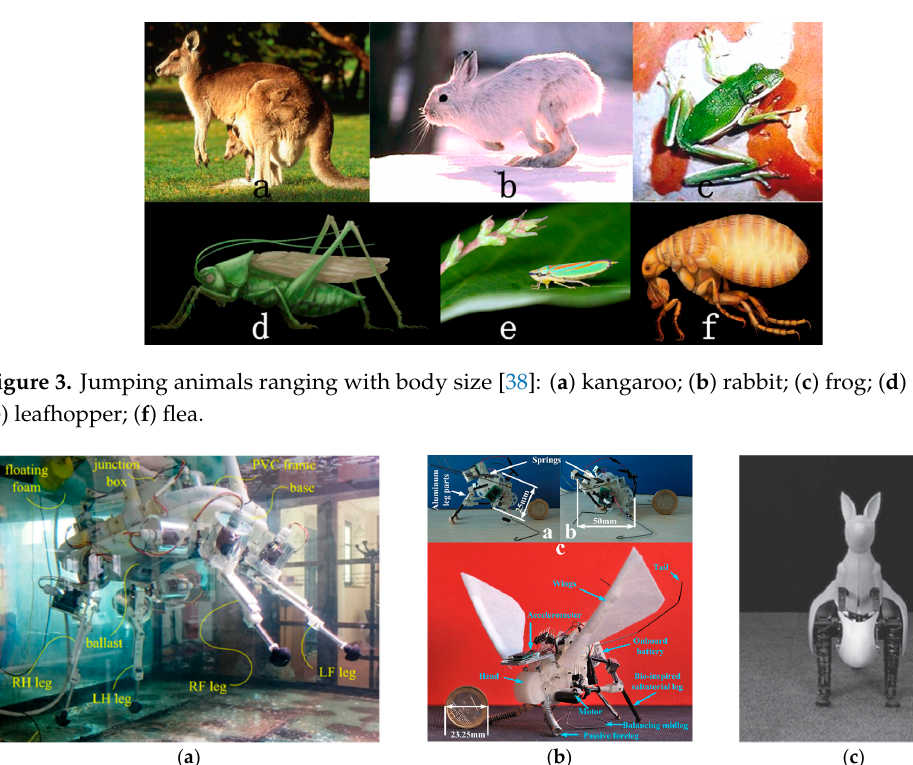
Figure 2. Classification of jumping animals in three subcategories: invertebrate, vertebrate, and aquatic jumping animals (including invertebrate and vertebrate animals).